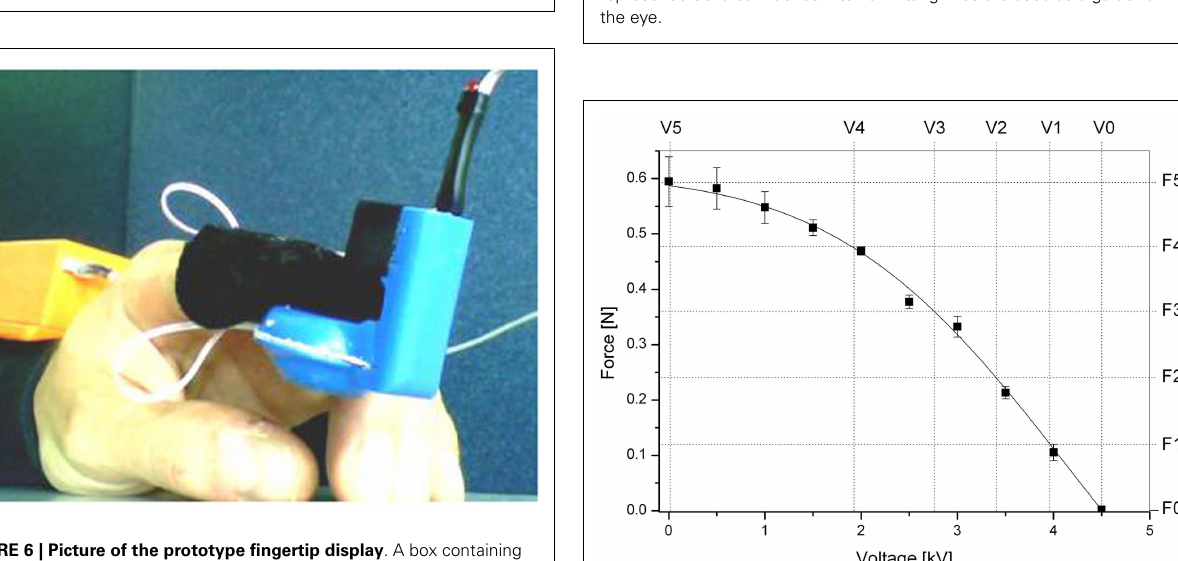
F5)usedduringtheperceptualtest(F0correspondstoanullforce).